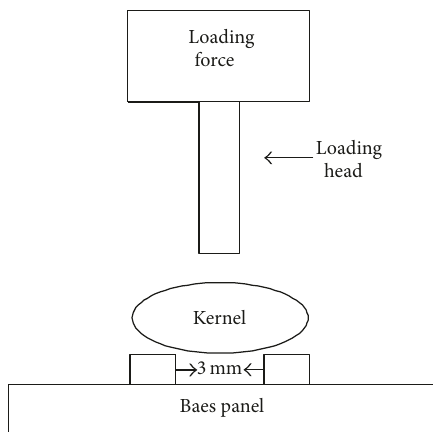
Figure 1: Schematic diagram of three-point bending deformation of rice kernel.